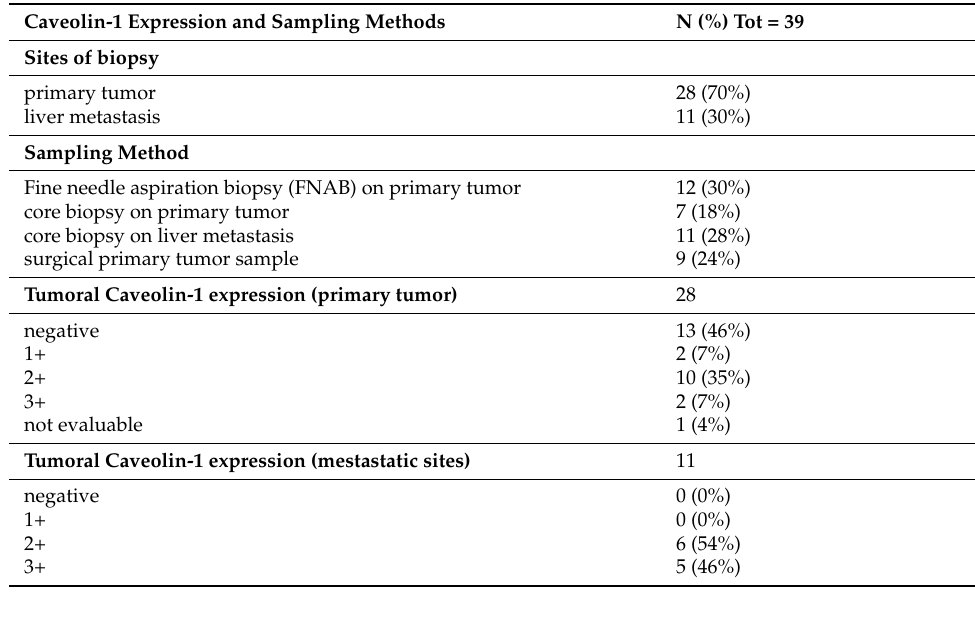
Table 3. Sites of biopsy and tumoral Caveolin-1 expression.